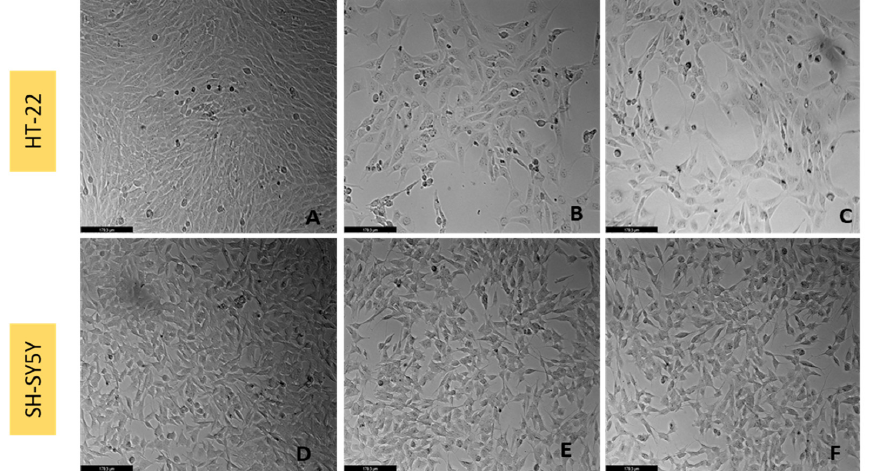
Figure 16. Representative images (100 × total magnification) of HT-22 and SH-SY5Y cells after incu- bation of corticosterone in combination with L-tryptophan. Cells were treated with ( A , D ) vehicle (0.1% Methanol/1%sterilized water), ( B ) L-tryptophan 10 nM + corticosterone 35 μ M, ( C ) L-trypto- phan 100 μ M + corticosterone 35 μ M, ( E ) L-tryptophan 0.1 nM + corticosterone 322 μ M, ( F ) L-tryp- tophan 100 μ M + corticosterone 322 μ M.